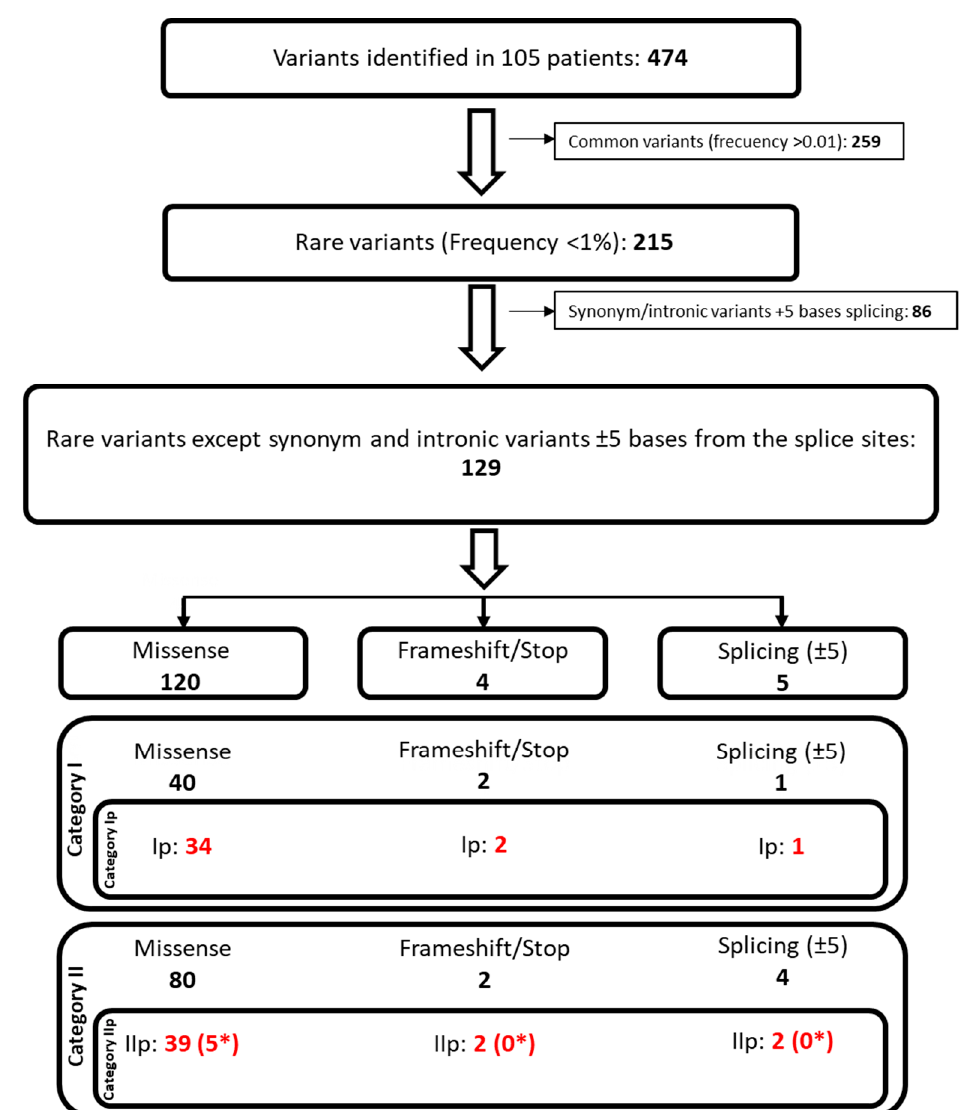
Figure 2. Schematic view of the followed steps for the filtering and classification of the variants identified in the patients of study. * Variants non-previously described. Red: category Ip (known mutation) and IIp (potential mutation) variants.